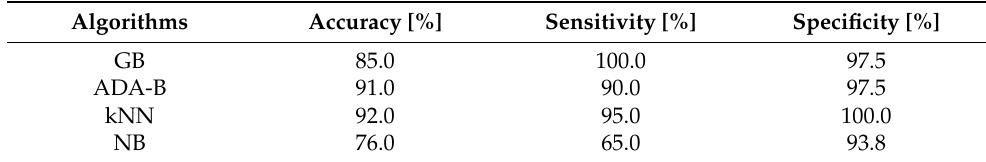
Table 4. Evaluation metrics per each algorithm.